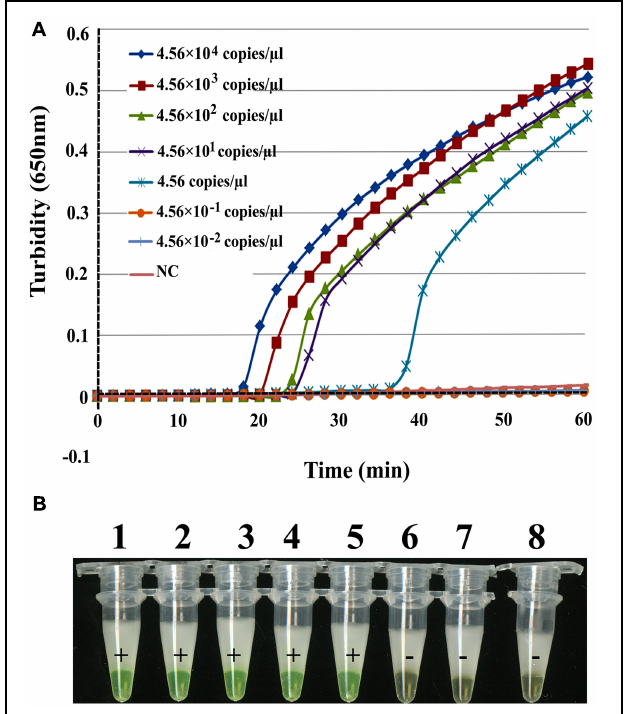
FIGURE 3 | Comparison of RT-LAMP sensitivities in detecting EBOV NP . Artificial EBOV RNA was serially diluted 10-fold from 4.56 × 10 4 copies/ µ L to 4.56 × 10 − 2 copies/ µ L. (A) Turbidity was monitored with a Loopamp Realtime Turbidimeter at 650 nm every 6 s. (B) The reaction was detected visually using a calcein fluorescent detection reagent. Artificial EBOV RNA concentrations were: tube 1, 4.56 × 10 4 copies/ µ L; tube 2, 4.56 × 10 3 copies/ µ L; tube 3, 4.56 × 10 2 copies/ µ L; tube 4, 4.56 × 10 1 copies/ µ L; tube 5, 4.56 copies/ µ L; tube 6, 4.56 × 10 − 1 copies/ µ L; tube 7, 4.56 × 10 −